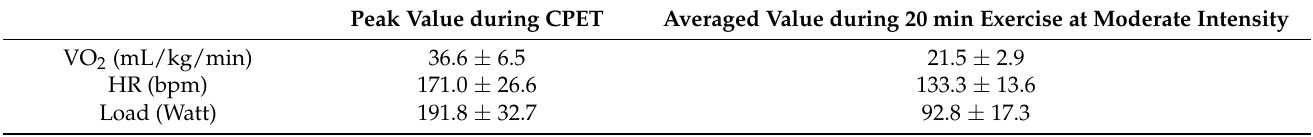
Table 1. Related parameters of exercise intensity (mean ± standard deviation).